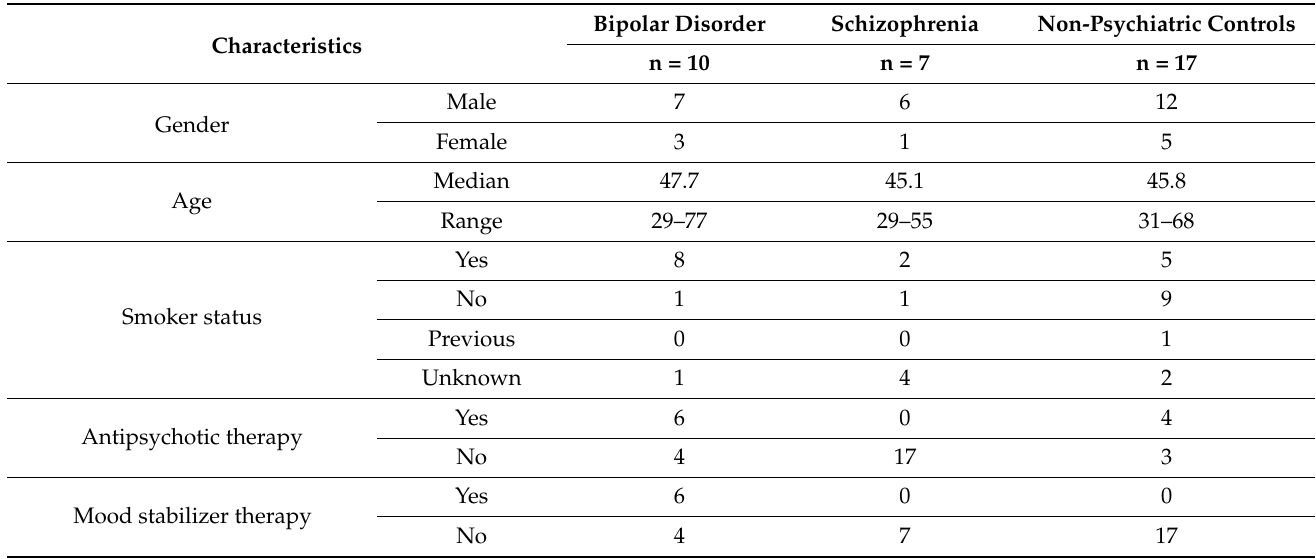
Table 2. GSE112523 study groups’ demographic and clinical characteristics, data from